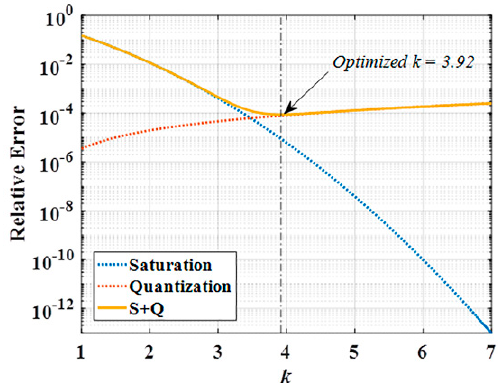
Figure 4. The relative noise of quantization and saturation at 8-bits. The ADC error is dominated by saturation or quantization noise when variable k is lower or higher than the optimum value, respectively.